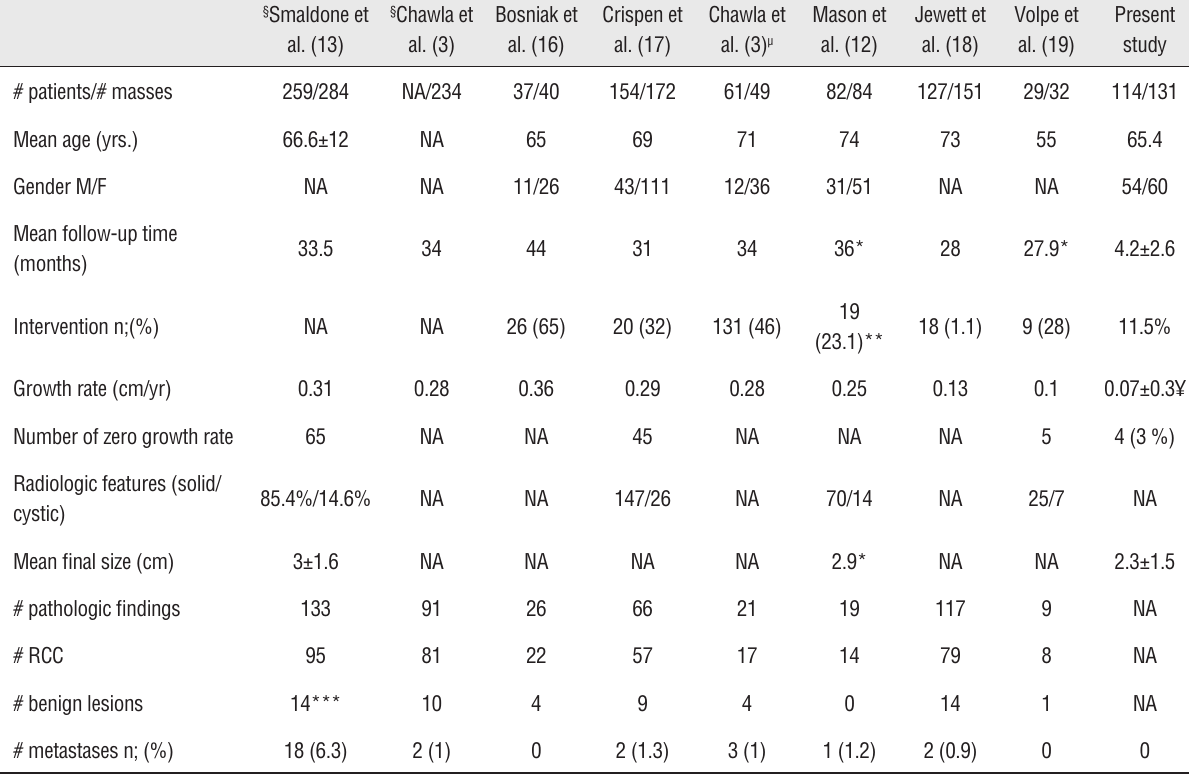
Table 3 - Renal mass surveillance studies and